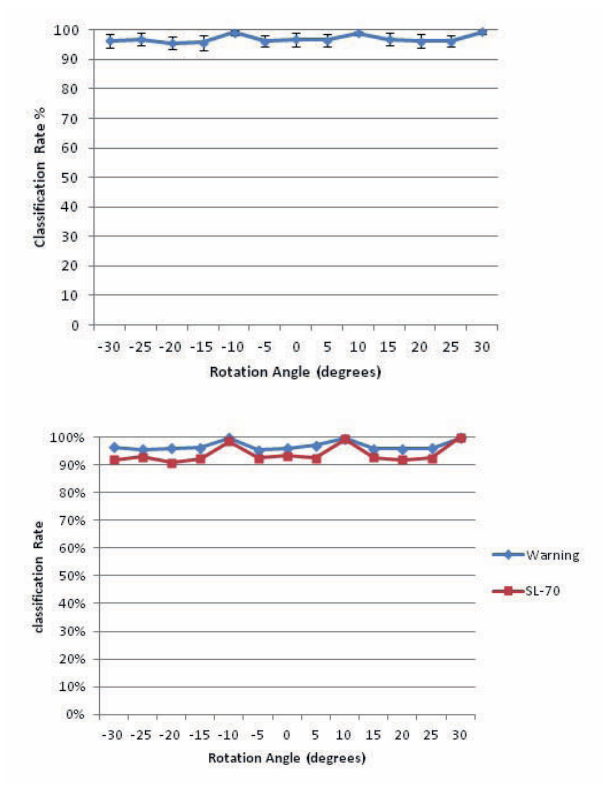
Figure 10. Recognition rate versus rotation angle. Top: average of all traffic sign classes. Bottom: recognition rate versus rotation angle for Warning signs and